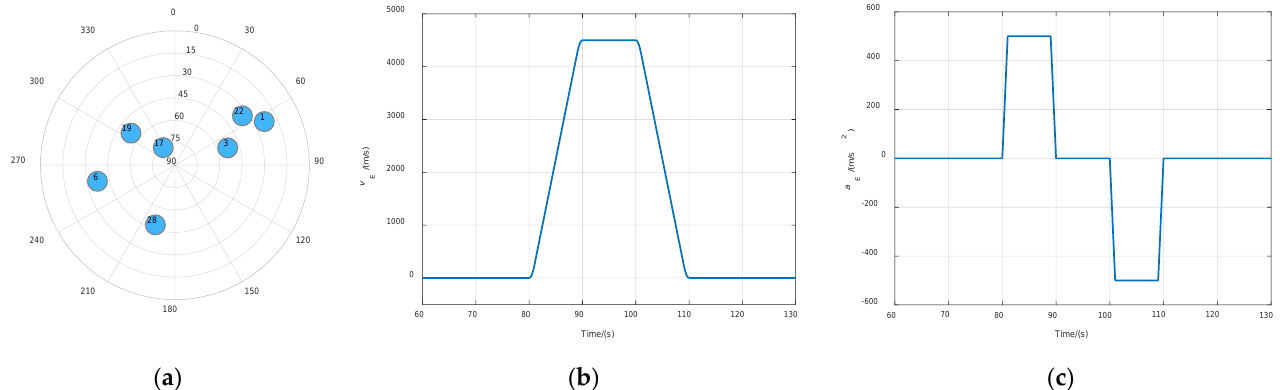
Figure 8. ( a ) Satellite constellation of experiment scenario; ( b ) curve of eastward velocity; ( c ) curve of eastward acceleration.